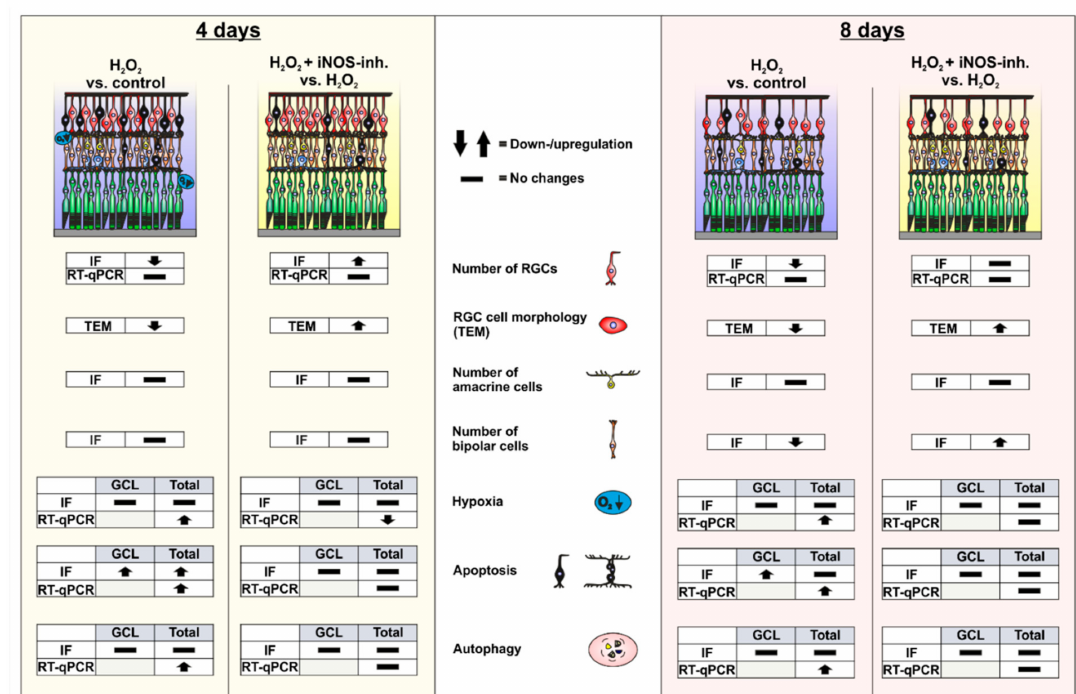
Figure 7. Graphical summary of the results. After four days of cultivation, morphological changes in the RGCs and loss of RGCs could be observed within H 2 O 2 -stressed retinas. In line with this, there was an increase in apoptosis in the ganglion cell layer and the total retina. In addition, an increase in the expression of hypoxic and autophagic genes could be detected. The iNOS-inhibitor 1400 W was able to stop RGC loss as well as the apoptotic, hypoxic, and autophagic processes. After eight days of cultivation, a decrease in RGC and bipolar cell numbers was observed in the H 2 O 2 -retinas. Apoptotic cells could now only be detected in the retinal ganglion cell layer. The loss of both cell types as well as some apoptotic and autophagic marker were normalized by the control by 1400 W treatment. Differences in the gene expression of hypoxic and autophagic genes could no longer be noted. GCL = ganglion cell layer; IF = immunofluorescence; TEM =